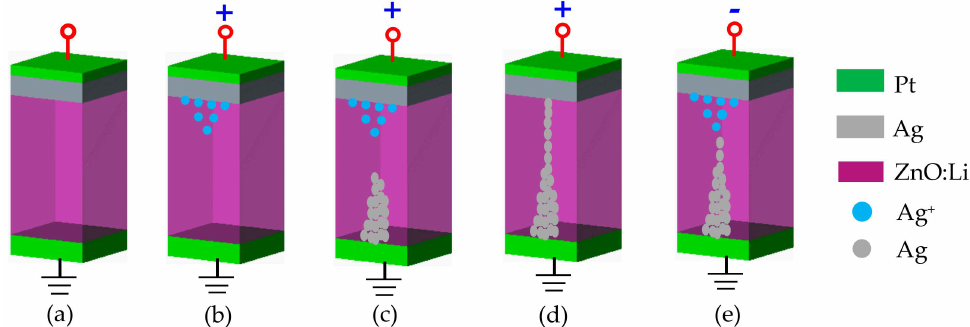
Figure 8. The schematic diagram for the mechanism of resistive switching e ff ects in Pt / Ag / ZnO:Li / Pt / Ti devices: ( a ) Initial state; ( b ) The TE Ag loses electrons and migrates to the BE at a positive bias voltage; ( c ) Ag + ions get electrons on the BE to become Ag atoms and grow toward the TE; ( d ) Forming conductive filaments; ( e ) When exerting a negative bias voltage, the conductive filament dissolves.